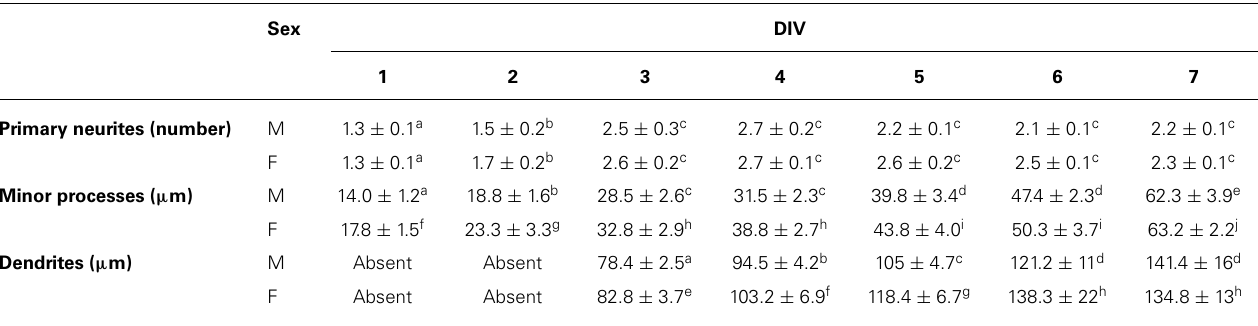
Data represent the mean ± SEM. n = 4–6 independent cultures for each sex. Different letters indicate statistical differences between groups (p < 0.05).